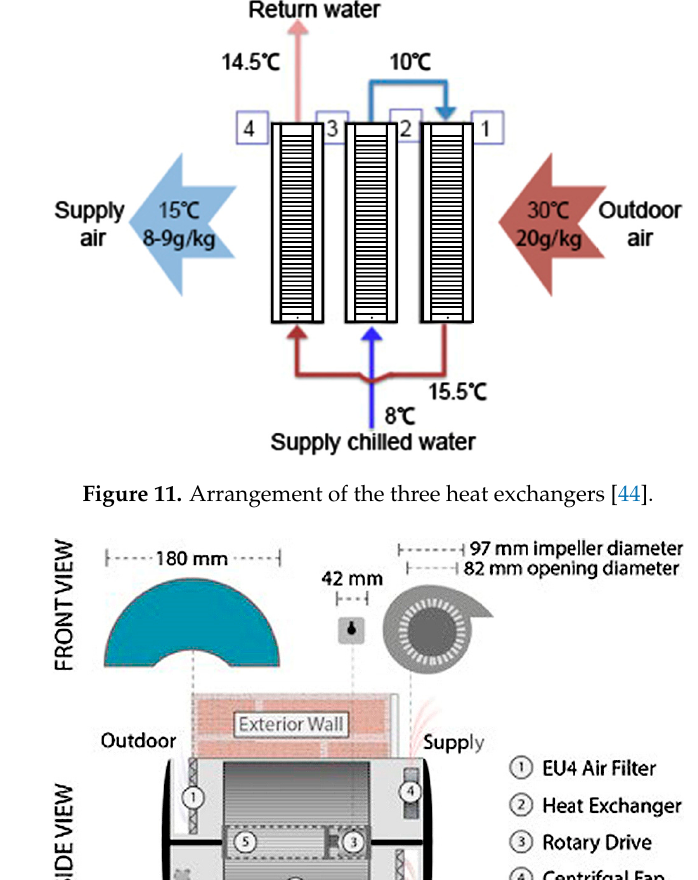
Figure 11. Arrangement of the three heat exchangers [44].